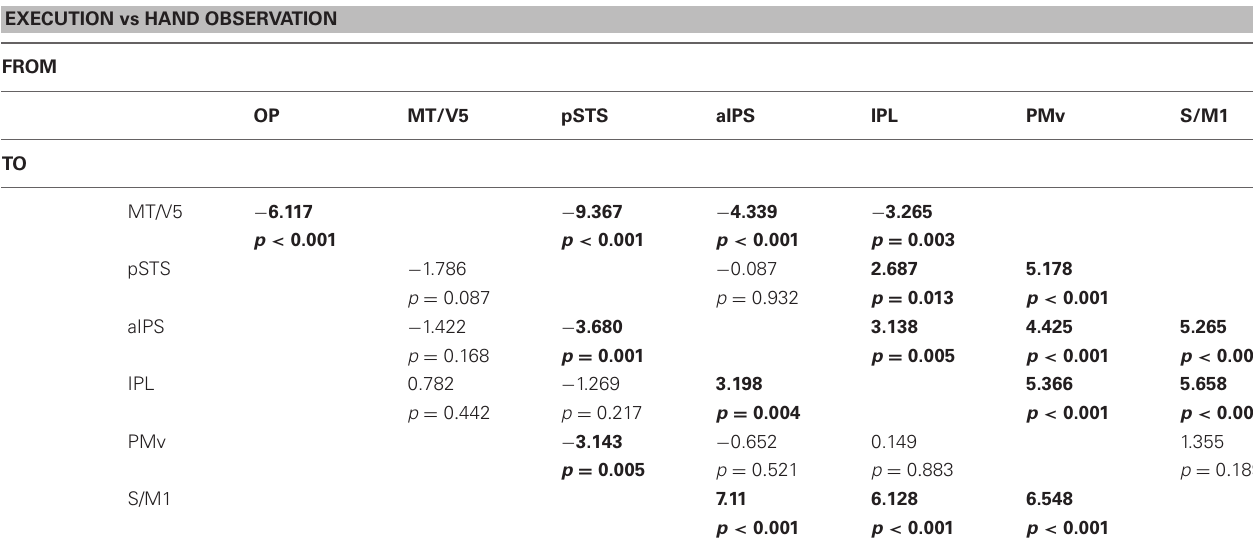
Solid arrows indicate positive modulation and broken arrows negative modulation. The values are the group averaged estimation of the modulation of the effective connectivity (Hz). IPL, inferior parietal lobule; pSTS, posterior part of superior temporal sulcus; PMv, ventral premotor; S/M1, primary sensorimotor cortex.